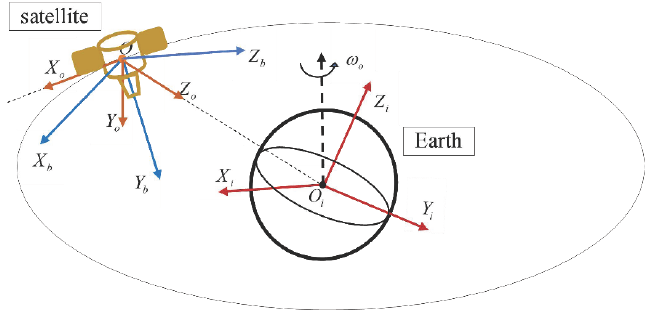
Figure A1. Spatial coordinate system.